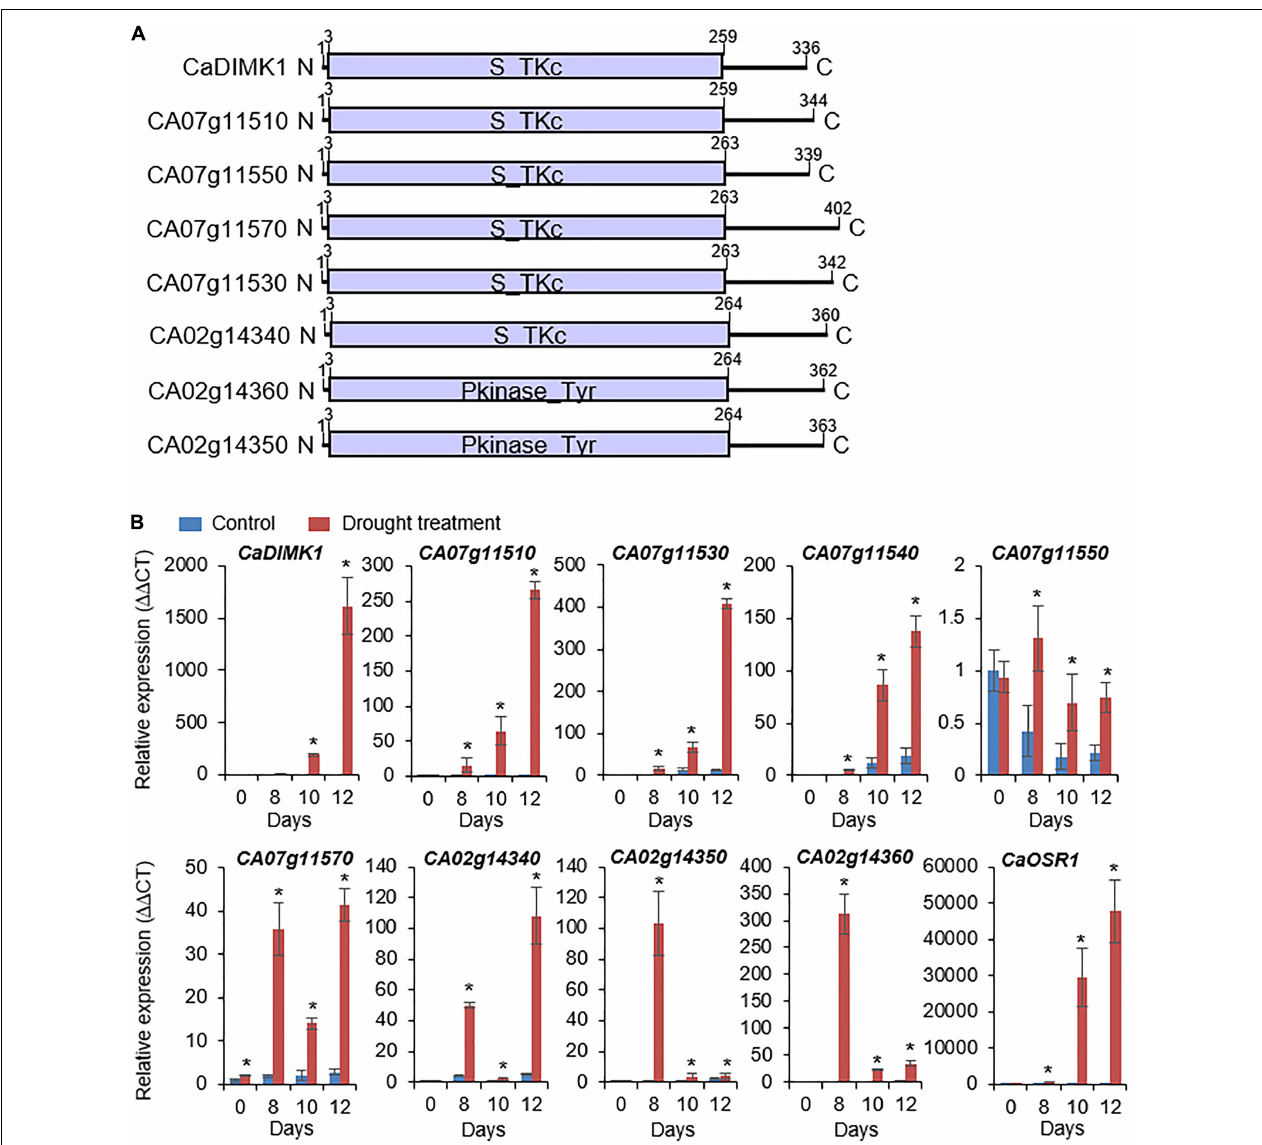
FIGURE 1 | Drought-induced pepper MAP3 kinase genes. (A) Protein domain analysis of pepper MAP3Ks according to deduced amino acids. The kinase domain was marked via released data (web address: http://smart.embl-heidelberg.de). (B) Induction levels of MAP3K genes in pepper leaf tissue after drought stress treatment. The expression values are normalized by pepper Actin1 ( CaACT1 ) gene as an internal control, and the induction level of each gene at 0 day was 1.0. As a positive control for drought treatment, CaOSR1 gene was amplified in parallel. Values are mean ± standard deviation, n = 3; asterisks indicate significant differences compared with nontreated control (Student’s t -test; * P <